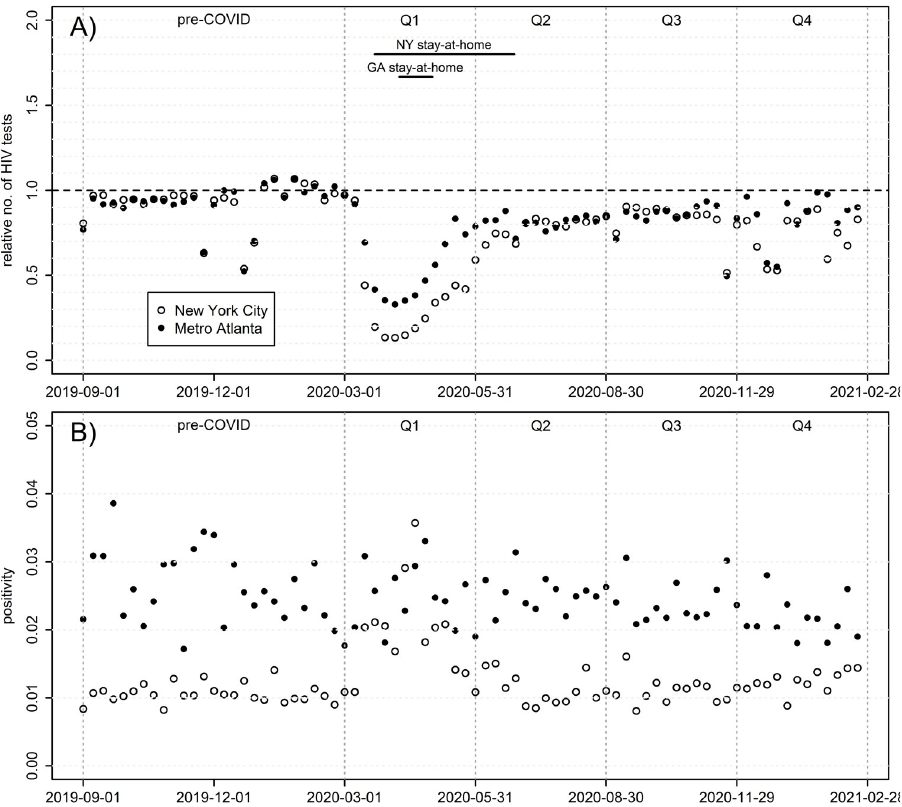
Fig 5. HIV testing among males, by week. A) Number of tests, relative to the weekly mean Feb. 2 –Feb. 29, 2020; B) positivity (proportion of valid tests with positive